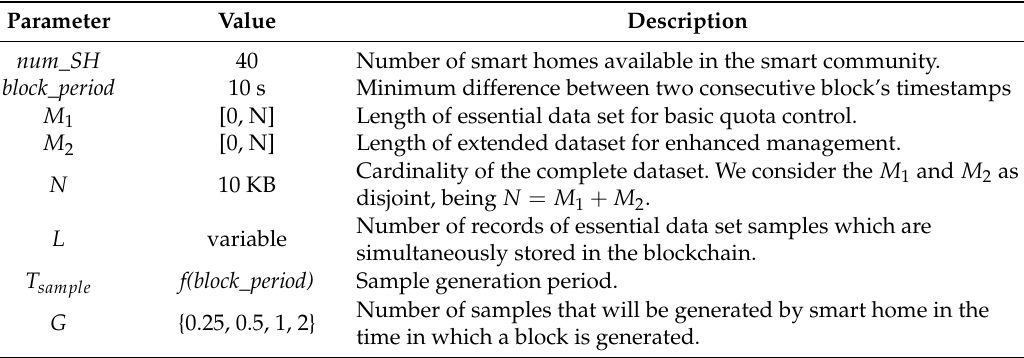
Table 3. Configuration parameters for performance